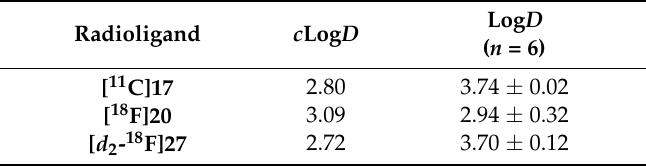
Figure 1. HPLC radiochromatograms for the separation of the radioligands [ 11 C]17 , [ 18 F]20 , and [ d 218 F]27 (panels A , C , and E , respectively) and the respective chromatograms for HPLC analyses of the formulated radioligands (panels B , D , and F , respectively). Table 3. Computed and measured log D values for Table 3. Computed and measured log D values for radioligands.